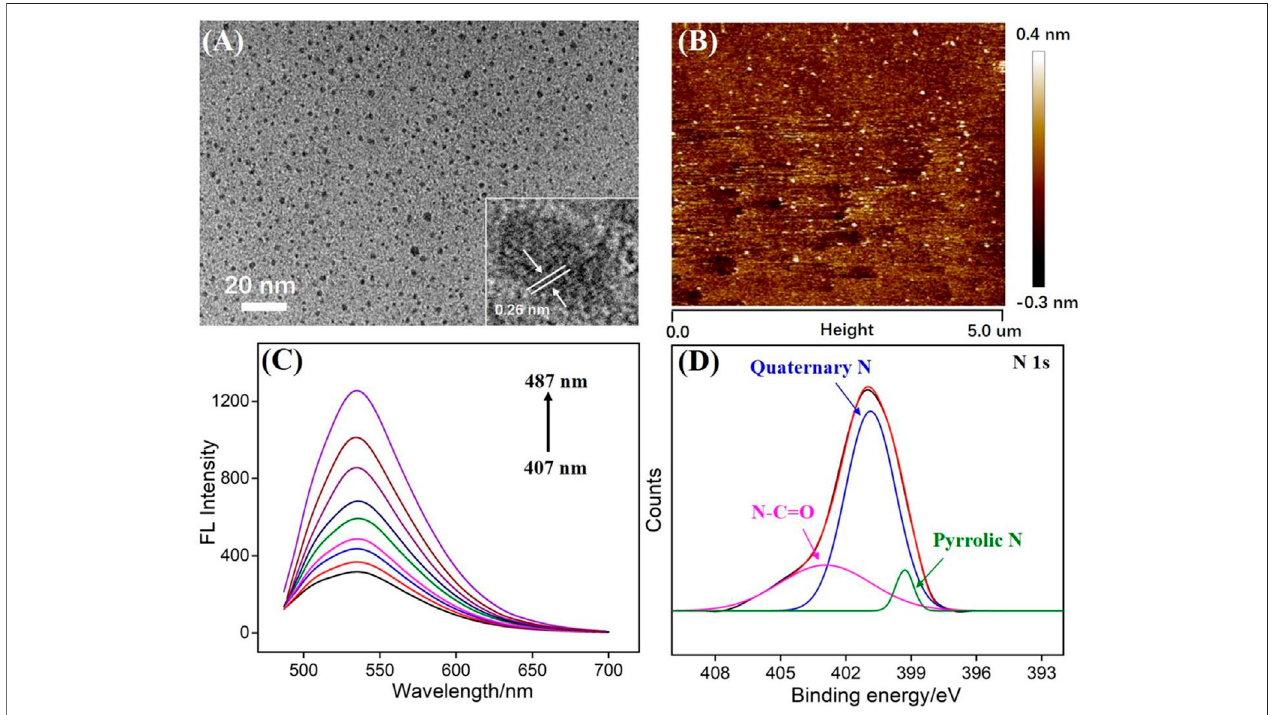
FIGURE 2 | (A) TEM images of N-GQDs. Insets present high-resolution TEM (HRTEM) image with resolved lattice. (B) AFM image of N-GQDs. (C) Fluorescence spectra of N-GQDs obtained with the excitation wavelength ranging from 407 to 487 nm (10 nm increment). (D) High-resolution XPS of N1s peaks from N-GQDs.